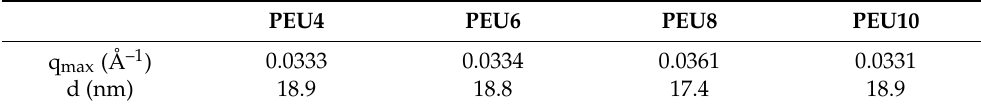
Figure 9. SAXS patterns of PEU. Table 4. Domain parameters of